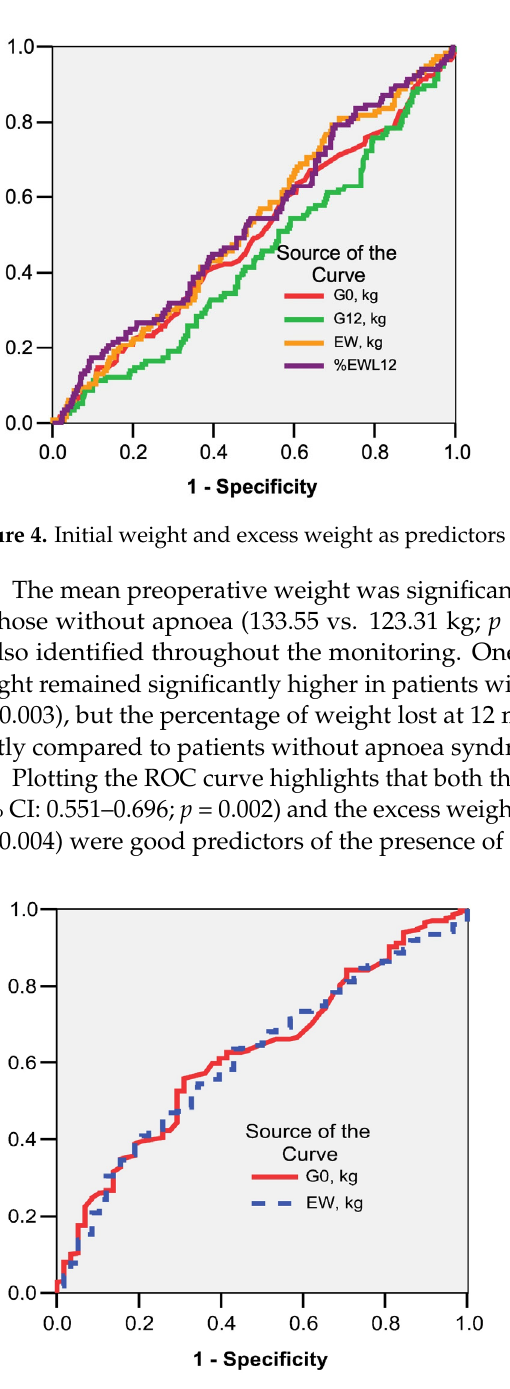
Figure 5. Initial weight and excess weight as predictors for sleep apnoea syndrome. Total cholesterol and LDL cholesterol levels decreased significantly during monitoring, from an average of 248.51 ± 46.04 mg/dL to 193.43 ± 41.11 mg/dL ( p = 0.001) and from 227.85 ± 77.63 mg/dL to 97.42 ± 17.52 mg/dL, respectively ( p = 0.001), and did not correlate with any specific type of intervention. Triglyceride levels decreased significantly during monitoring, from a mean value of 350.40 ± 160.77 mg/dL to 212.81 ± 136.73 mg/dL ( p = 0.001) at the end of the follow-up. Mean blood glucose levels decreased significantly during monitoring, from an average of 112.53 ± 60.88 mg/dL to 91.38 ± 15.77 mg/dL ( p =